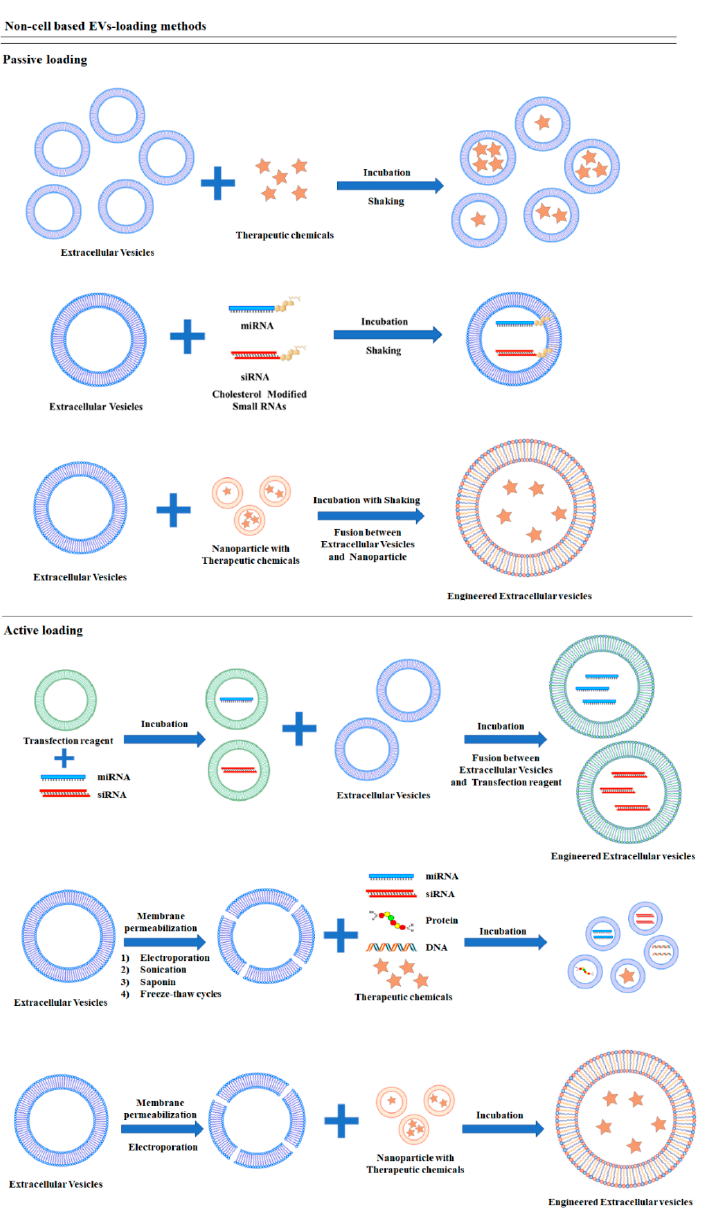
Figure 2. Schematic diagrams of non-cell-based cargo loading methods.